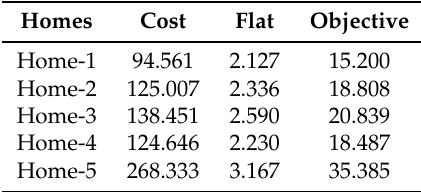
Table 6. Consumer survey results.